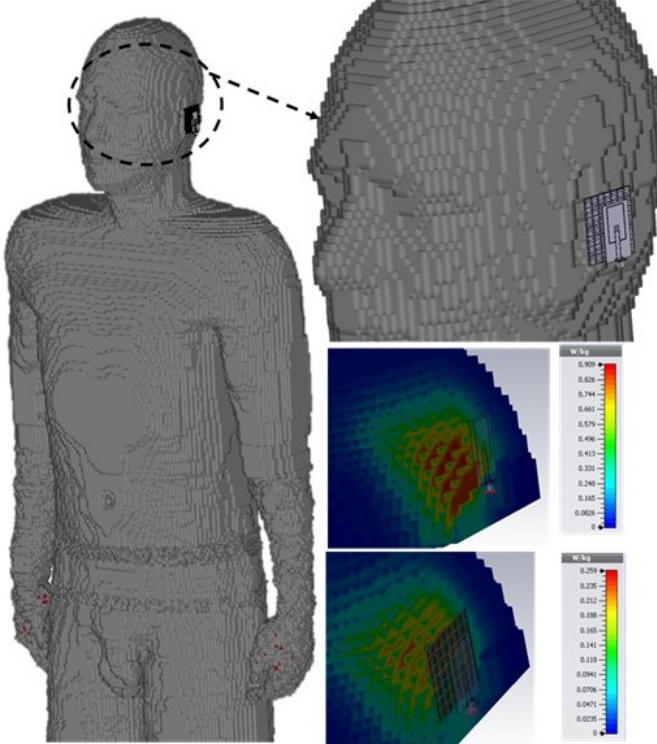
Figure 8. 3-D model of SAR calculator set-up that consists of a Voxel model, the antenna close to the head and ear of the body, and simulated SAR results for CPW without MD-AMC board ( top ) and CPW with MD-AMC board ( bottom ).